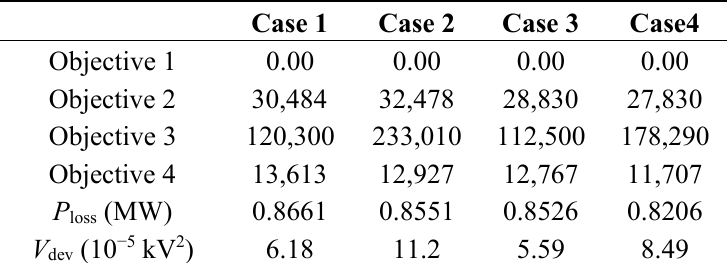
Table 2. Index comparison of BESS optimizing.